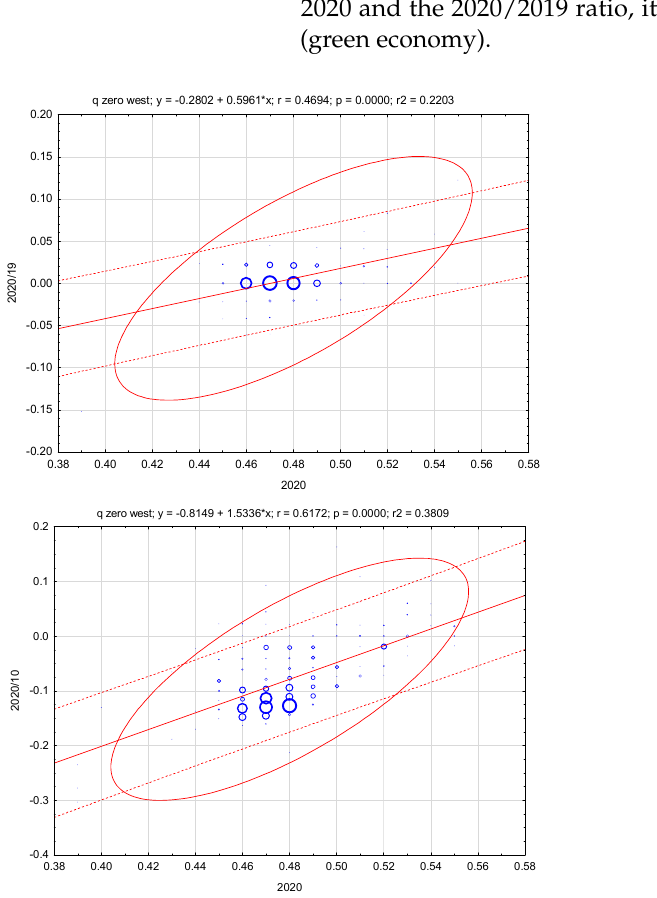
Table 7. Coefficients of correlation between the value of the synthetic measure, waste management, green economy and diagnostic variables of their structure for districts in 2020 and 2020.